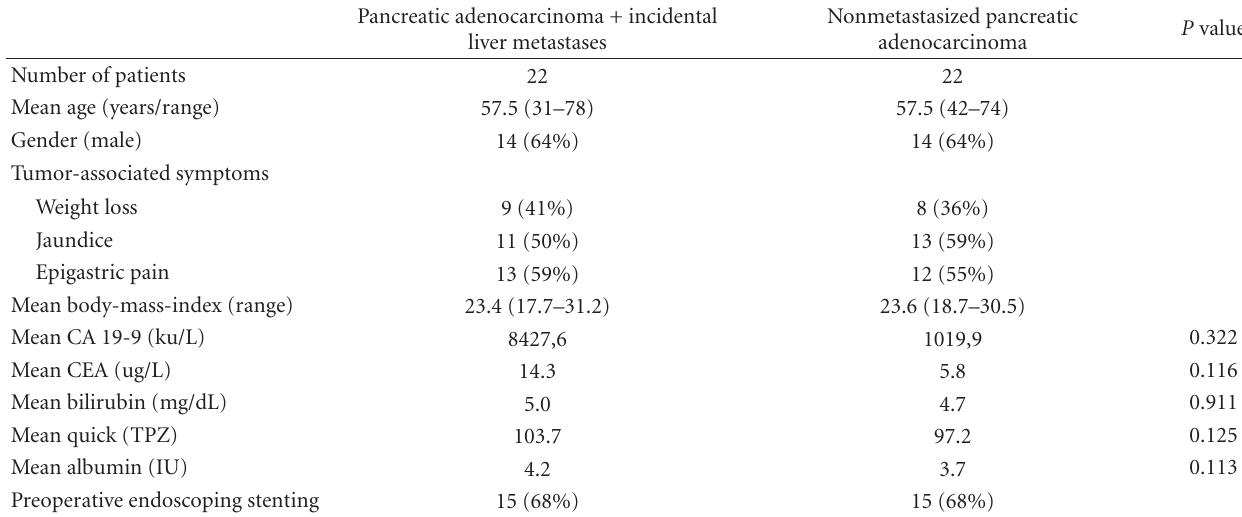
Table 1: Patients